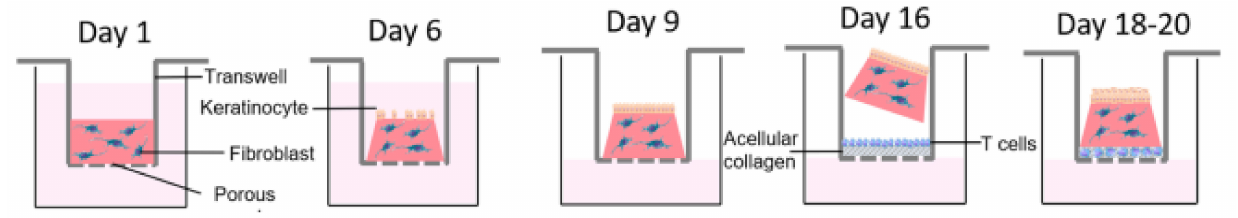
Figure 3. Schematic showing construction of a psoriasis model incorporating T cell infiltration. Adapted from [66], published by Nature Portfolio,